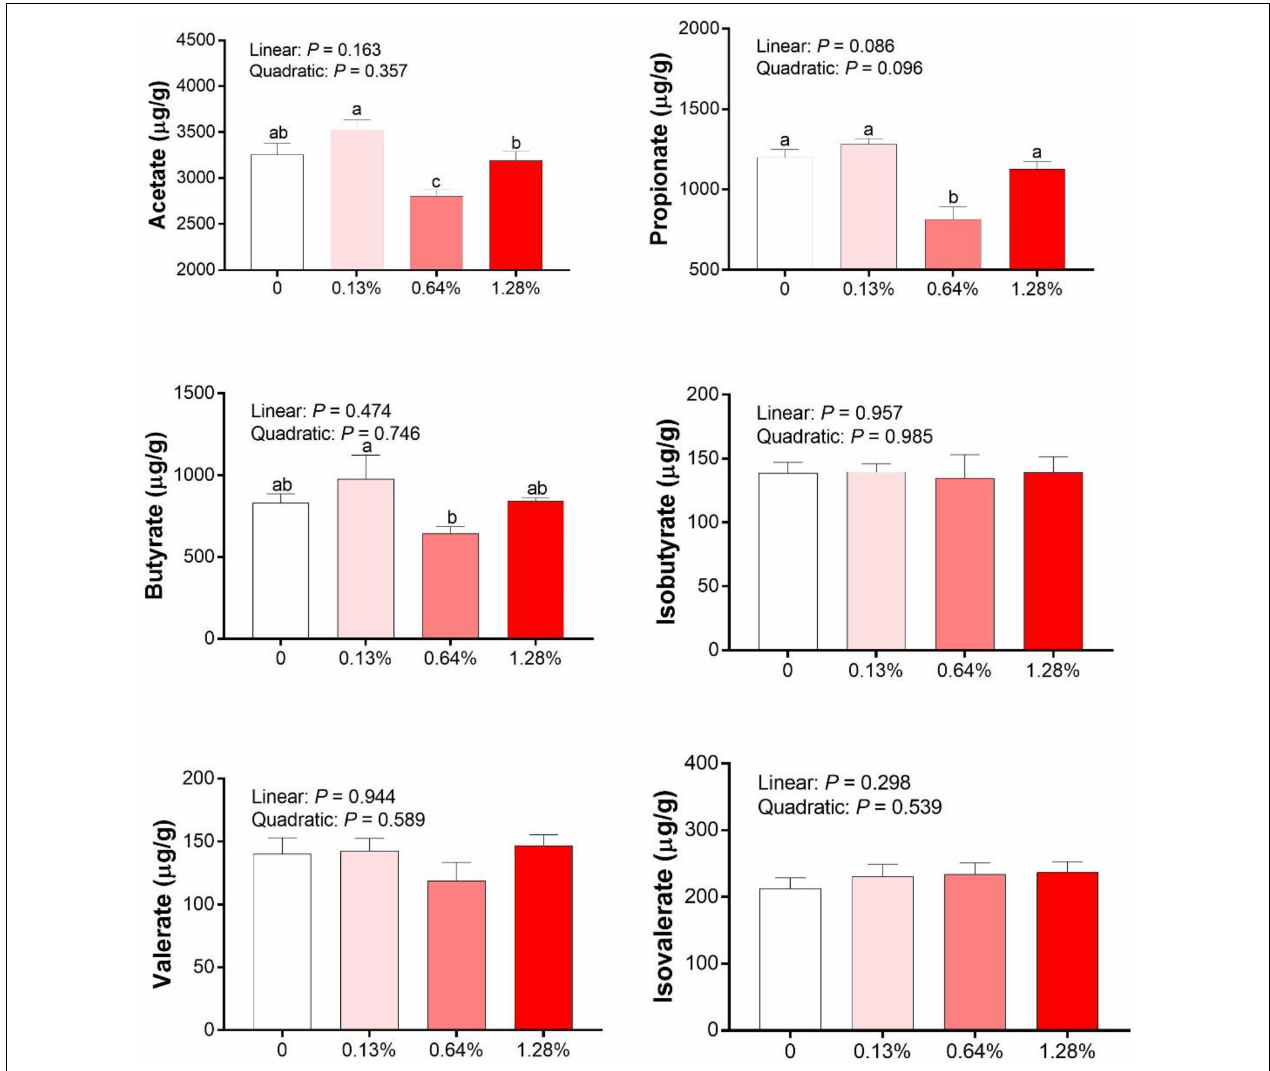
FIGURE 3 | The SCFAs concentrations in the colonic contents of Bama Xiang mini-pigs. Data are presented as mean ± SEM ( n = 8). a , b , c Values with different letters are significantly different among dietary HMB treatments ( P <